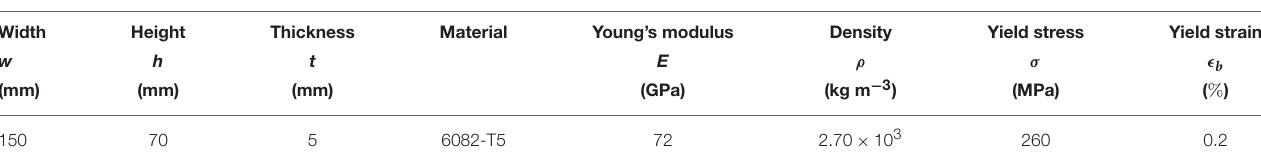
TABLE 1 | Geometric and mechanical data of 6082-T5 Aluminum